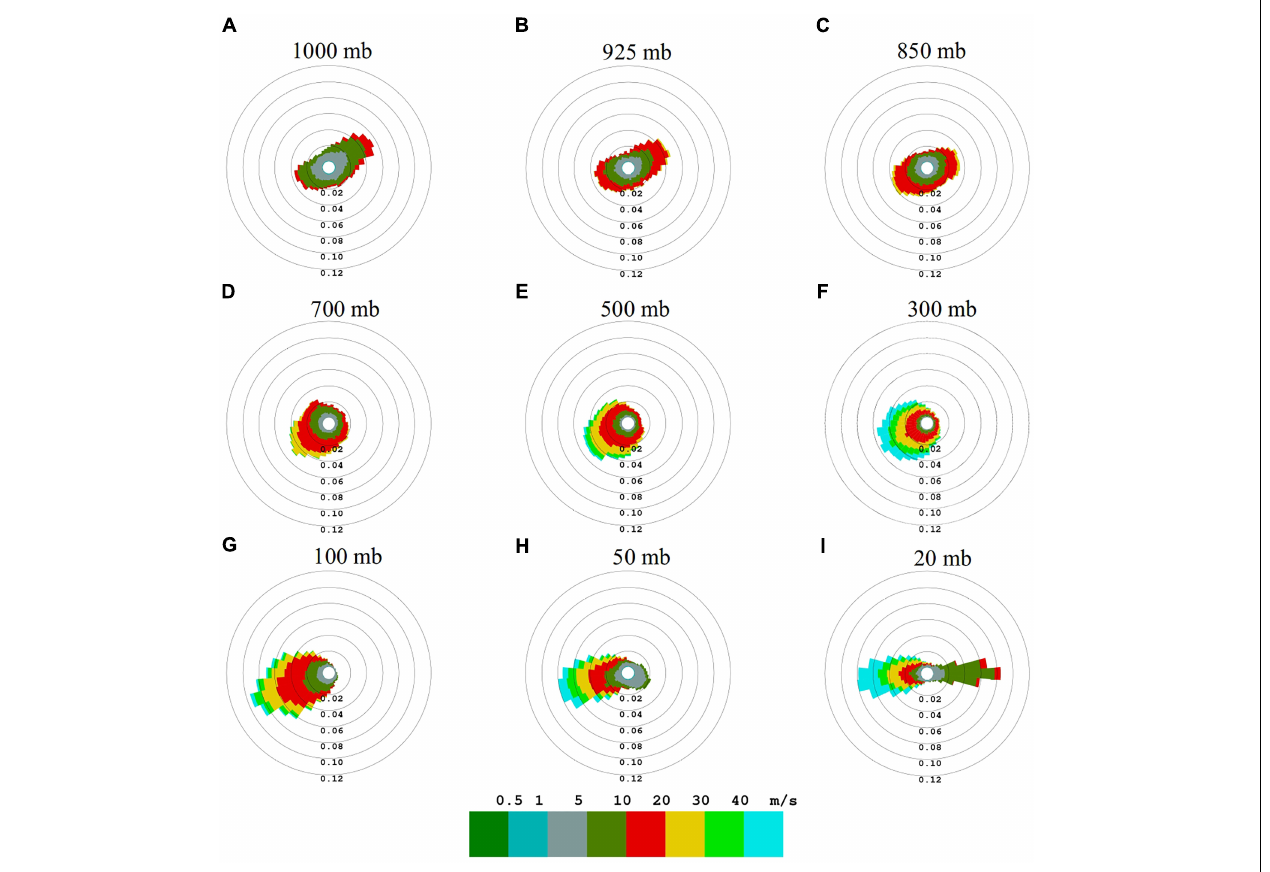
FIGURE 5 | The nine windroses show the wind direction (the sectors correspond to the direction from which the wind blows) and speed (different colors) at different altitudes over Vatnajökull glacier. 1000 mb corresponding roughly to the ground level up to 20 mb corresponding about to 24000 m asl. Ten years of ECMWF data (1980–1990) have been processed to produce these